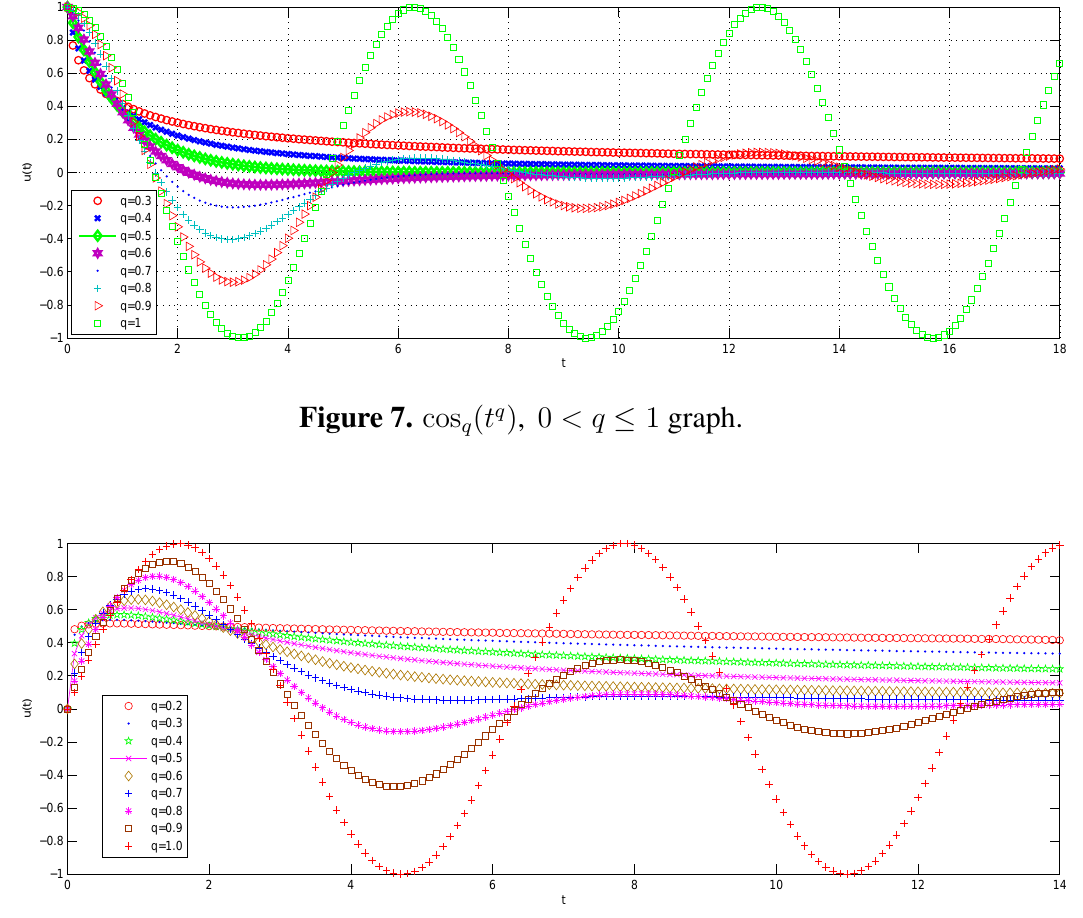
( t q ) , 0 < q ≤ 1 graph. q